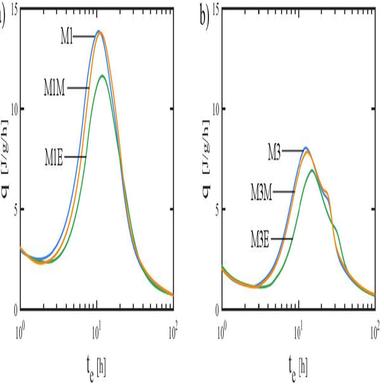
Schematic representation of n-octyl-ethoxy silane (left) and silicone resin (right).